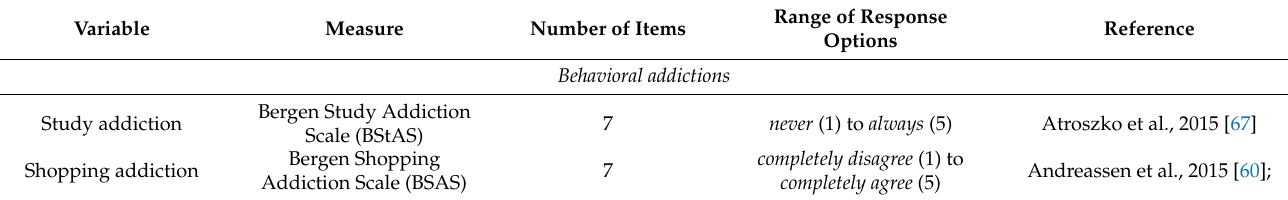
Table 3. Characteristics of the Study